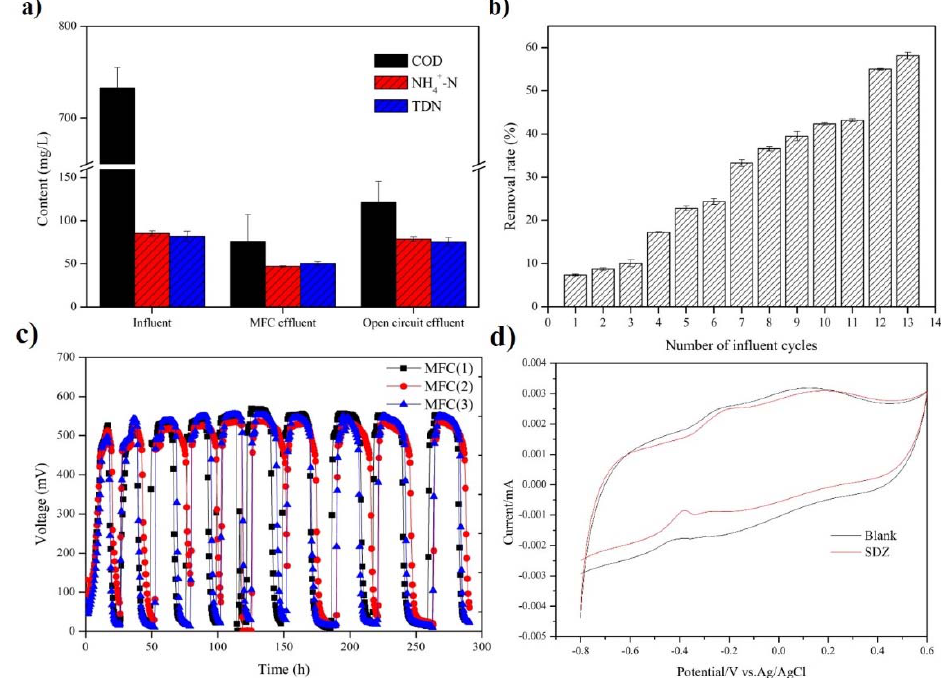
Figure 1. Performance of the air-cathode system: ( a ) Contents of COD, NH 4+ -N, and DTN in MFCs; ( b ) Removal rate of SDZ; ( c ) Output voltage; ( d ) CV curves.